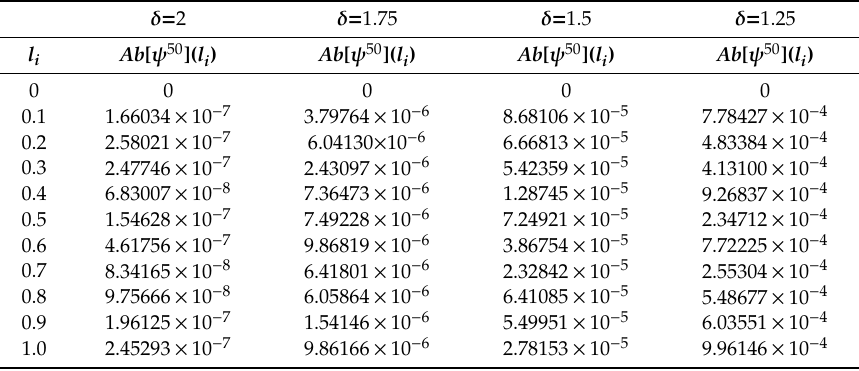
Table 2. Numerical results of Example 2 using RKDM.